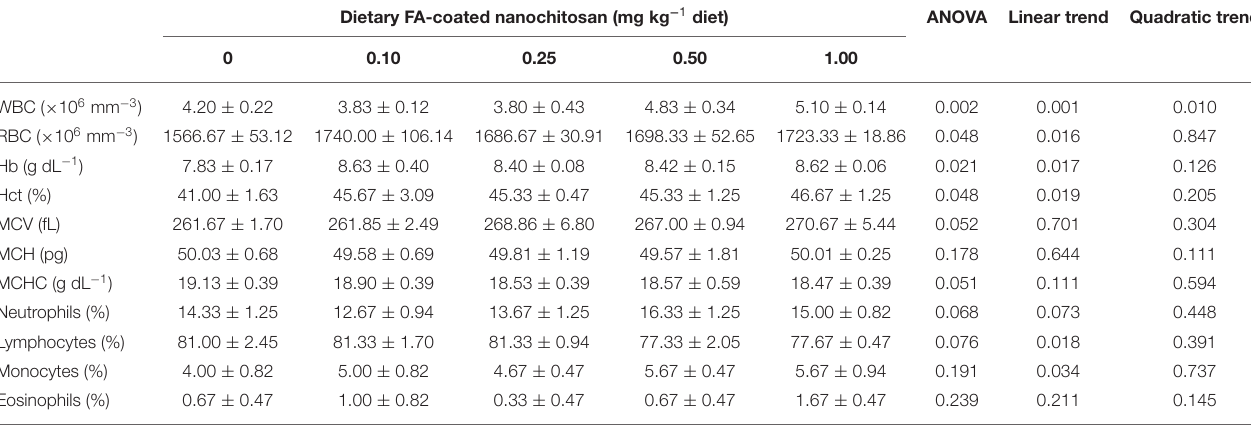
TABLE 3 | Hematological parameters of fingerling rainbow trout, Oncorhynchus mykiss , fed diets containing varying levels of folic acid-coated nanochitosan*. Dietary FA-coated nanochitosan (mg kg − 1 diet) ANOVA Linear trend Quadratic trend